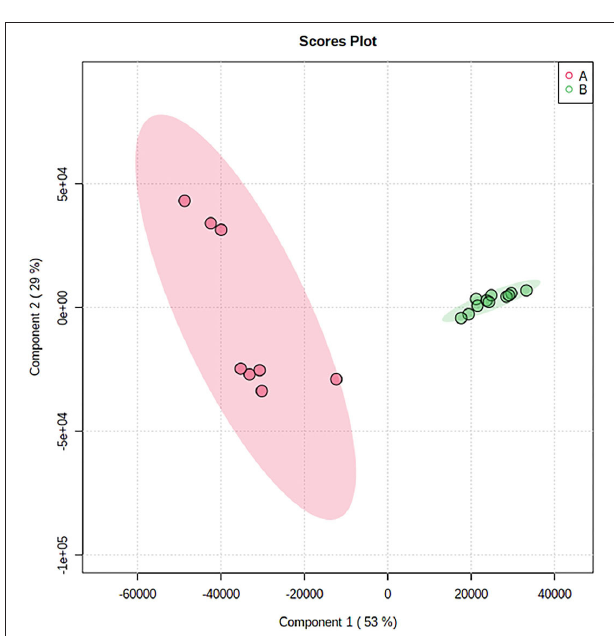
FIGURE 5 | PLS-DA score plot showing the discrimination of the samples according to their species; Tuber Aestivum samples are grouped together in the red ellipse, and Tuber Borchii samples are grouped together in the green ellipse.